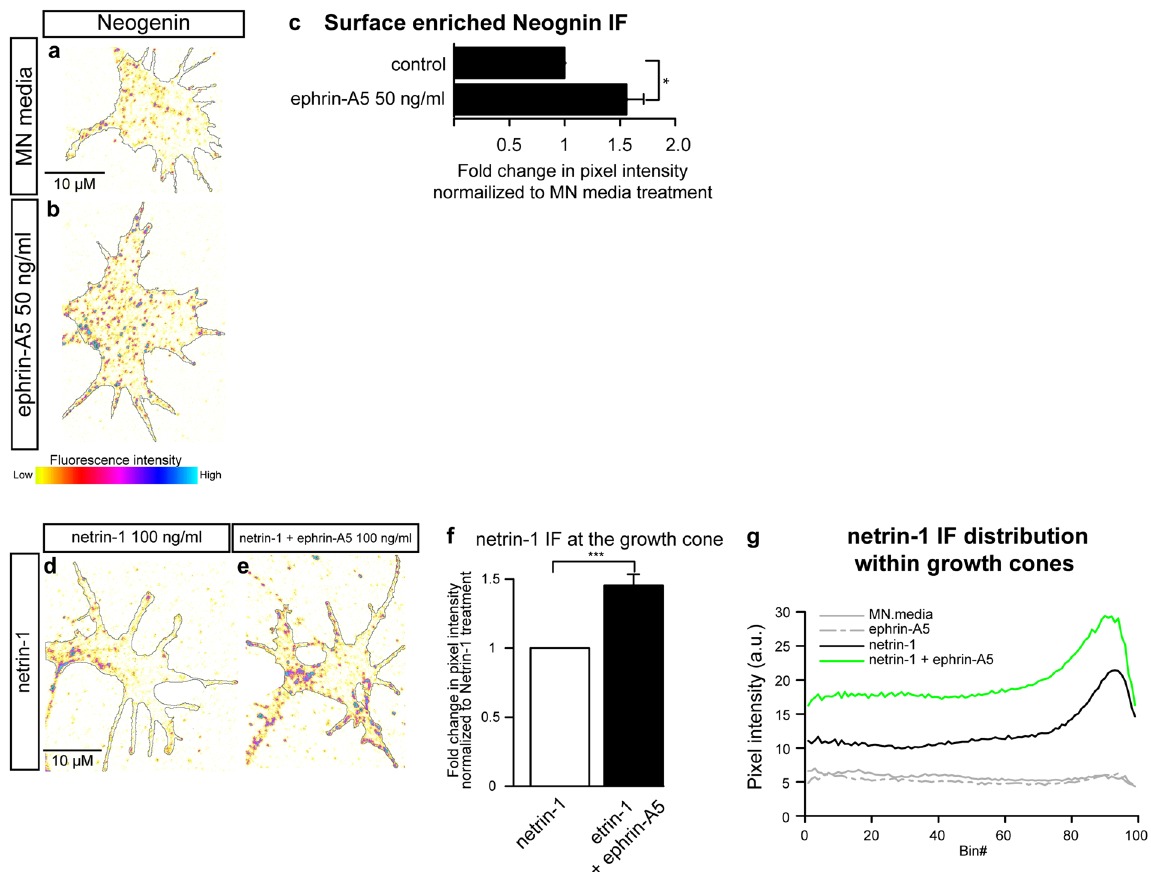
Figure 4. Exposure to ephrin-A5 increases surface enriched Neogenin protein levels and netrin-1 binding to LMC growth cones. Examples of surface-enriched Neogenin in MN media ( a ) or ephrin-A5 50 ng/mL ( b ) treated LMC growth cones. ( c ) Quantification of surface enriched Neogenin IF in LMC growth cones treated with either MN media or ephrin-A5 50 ng/mL for 20 ′ , ephrin-A5 increases surface enriched Neogenin IF 1.6 ± 0.2-fold, p = 0.037. ( d , e ) Examples of netrin-1 IF in LMC growth cones treated with either netrin-1 ( d ) or a combination of netrin-1 and ephrin-A5 (100 ng/mL). ( f ) Quantification of netrin-1 IF in growth cones treated with netrin-1 or netrin-1 + ephrin-A5, addition of ephrin-A5 results in a 1.5 ± 0.1-fold increase in netrin-1 IF (p = 0.0003). ( d ) Graph depicting the distribution of netrin-1 IF in growth cones of explants treated with either MN media, ephrin-A5, netrin-1 or netrin-1 + ephrin-A5. Bin #1 coincides with the geometric centre of the growth cone and Bin# 99 coincides with the perimeter of the growth cone. Data are shown as mean ± SEM, statistical significance was tested using a two-tailed unpaired sample t-test. ( c ) N = 4 ( f , g ) MN media: N = 3; netrin-1: N = 6; ephrin-A5: N = 6; netrin-1 + ephrin-A5: N =